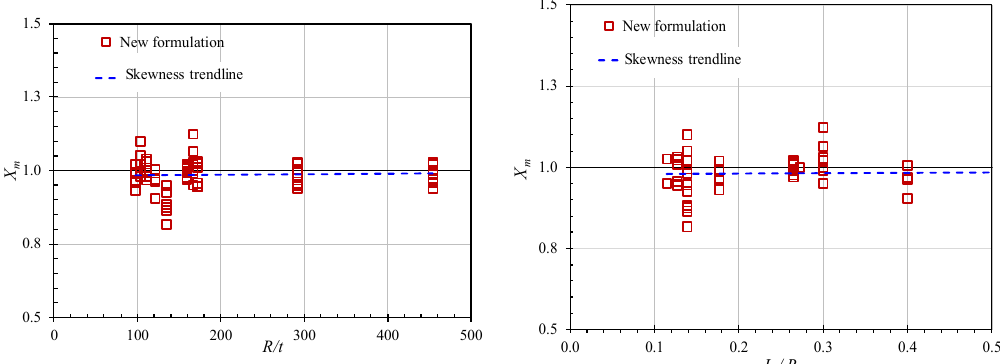
Figure 22. Skewness of the proposed formula against the basic parameters R/t and L s /R for the ring-stiffened cylinder.